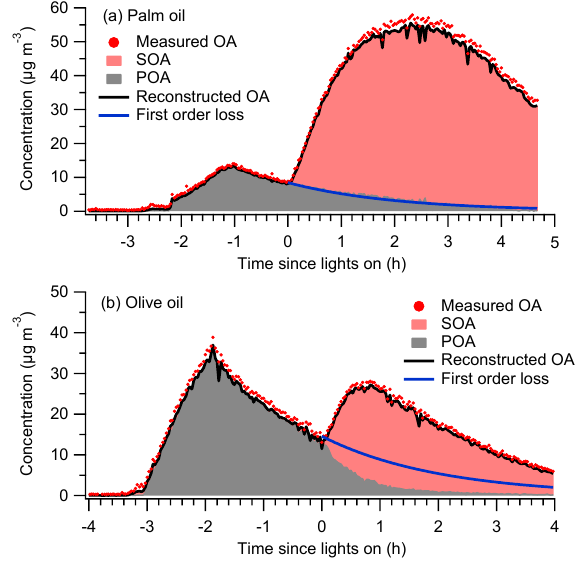
Figure 1. Time series of measured OA, PMF factors, and POA concentrations assuming first-order loss of POA to the walls for (a) palm and (b) olive oil experiments. Concentrations were not cor- rected for particle wall